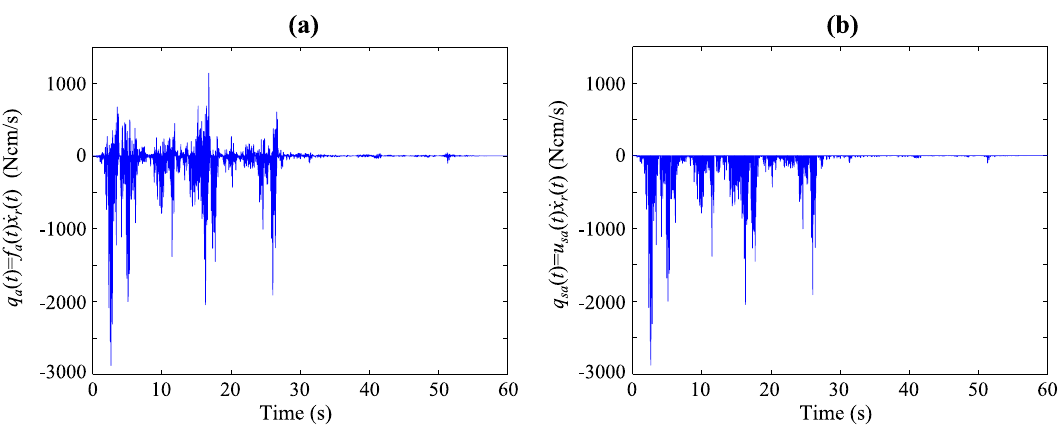
Figure 2. Indicative example of the “power” scheme/demand practised in ( a ) active; and ( b ) semi ‐ active control.